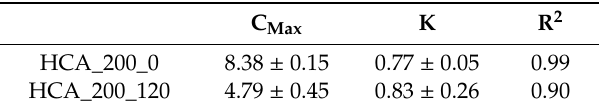
Table 5. Synopsis of regression parameters for Langmuir